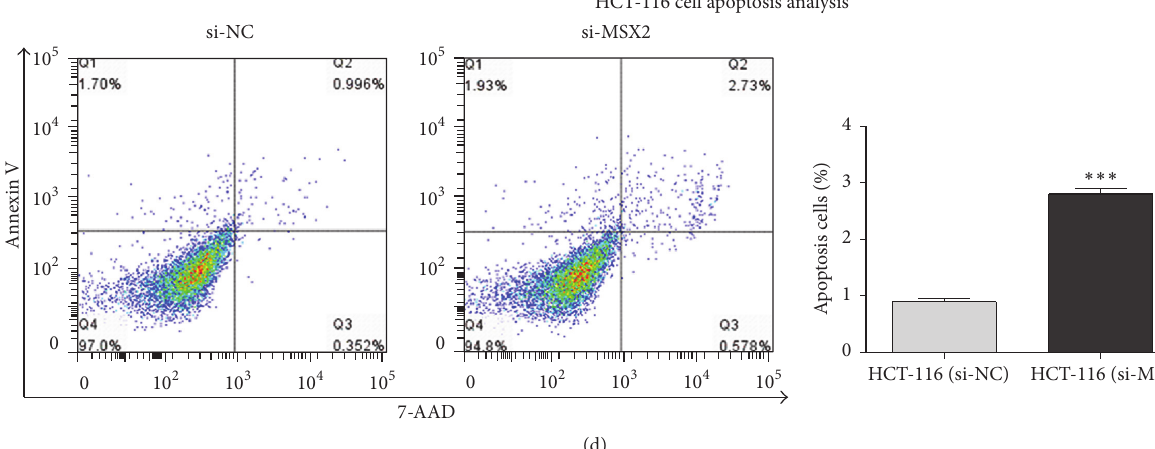
Figure 4: Knockdown of MSX2 expression promoted the cell cycle arrest and apoptosis of CRC cell line. HCT-8 (a, c) and HCT-116 cells (b, d) were harvested after transfection with si-MSX2 and si-NC for 48 h. (a, b) Representative histograms of cell cycle distribution detected by flow cytometry for PI-staining. The green, blue, and yellow peaks represent G1 stage, G2 stage, and S stage, respectively (left panel); data summary of the proportion of cell cycle distribution (right panel) ( ∗ 𝑃 < 0.05 , ∗∗ 𝑃 < 0.01 , ∗∗∗ 𝑃 < 0.001 , compared with NC). (c, d) Representative dot-plots of apoptosis detection by flow cytometry for Annexin V-PE and 7-AAD staining (left panel); data summary of the proportion of apoptotic cells with Annexin V + 7-AAD + cells (right panel) ( ∗∗ 𝑃 < 0.01 , ∗∗∗ 𝑃 < 0.001 , compared with NC). Error bar value represented at least 3 independent experiments (mean ±